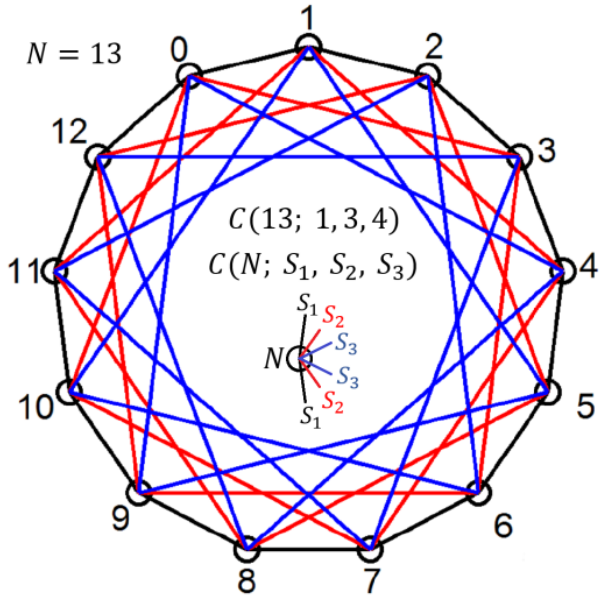
Figure 1. The Paley graph of order 13.